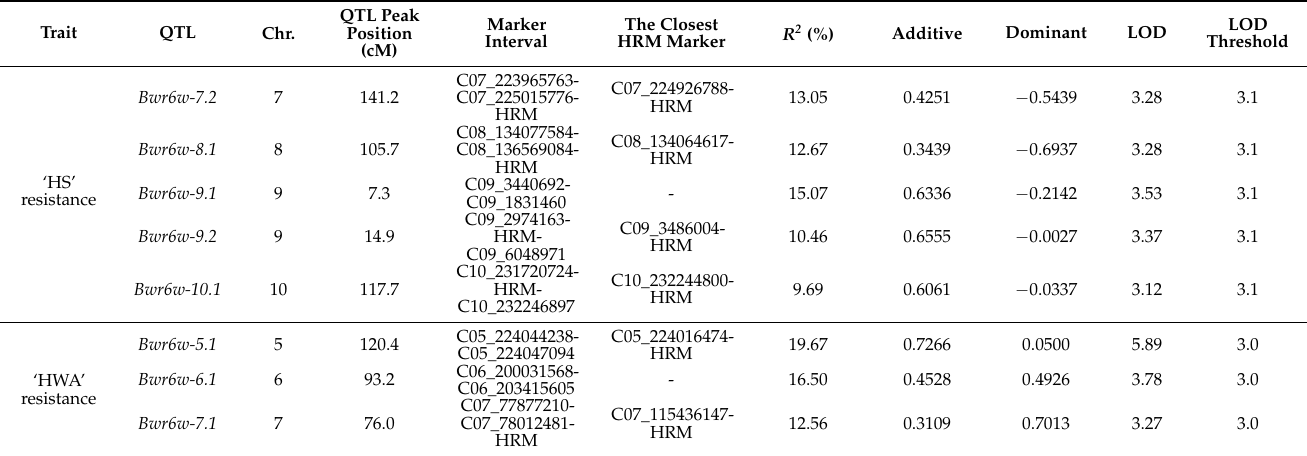
Table 4. Summary of QTLs for pepper resistance to bacterial wilt caused by two different isolates, a moderately pathogenic ‘HS’ and a highly pathogenic ‘HWA’, of Ralstonia solanacearum .